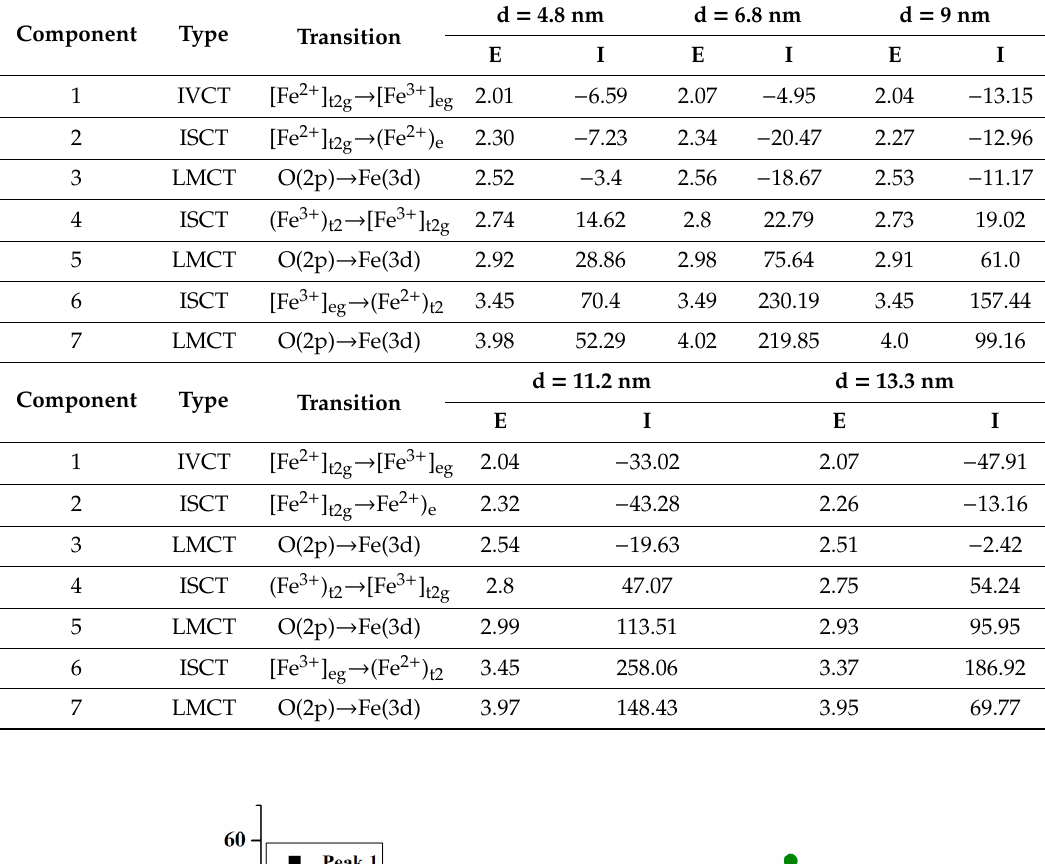
Table 3. Results of the fit analysis of the MCD spectra of the Fe 3 O 4 nanoparticles. The tetrahedral and octahedral sublattices are denoted as () and [], respectively. E—peak position (eV); I—peak intensity (arb. unit).